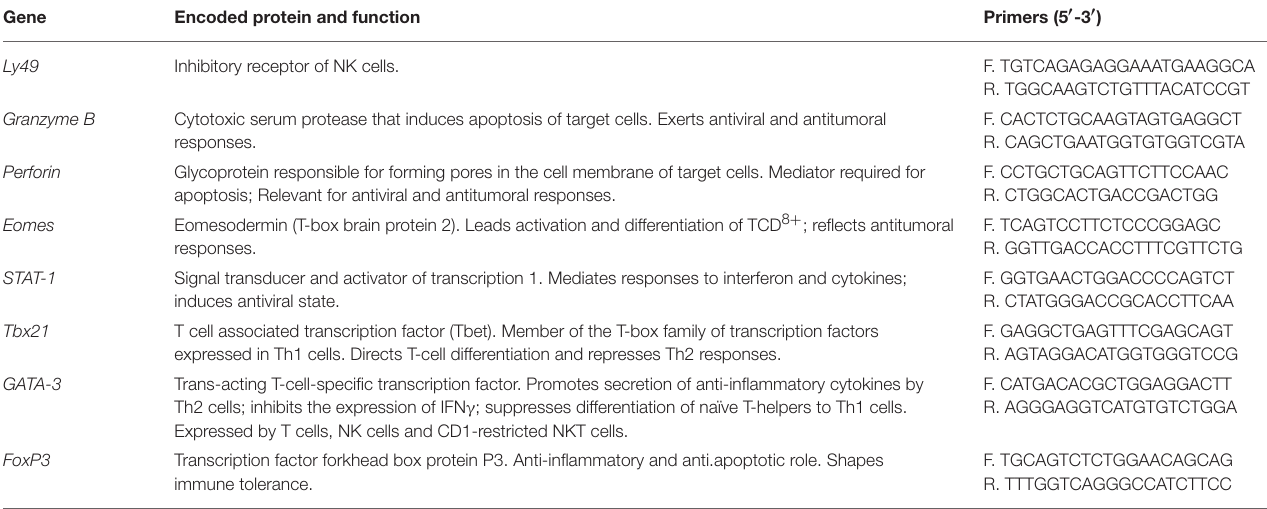
TABLE 1 | Genes selected as markers of NK and CD 8 + cytotoxicity, Th2 responses and immunomodulation. Gene